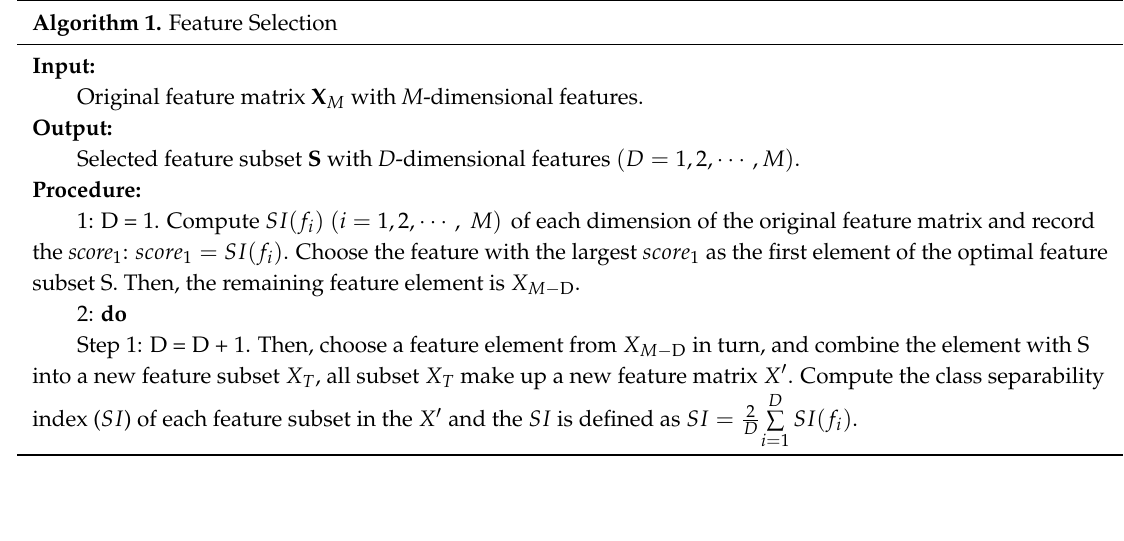
Algorithm 1. Feature